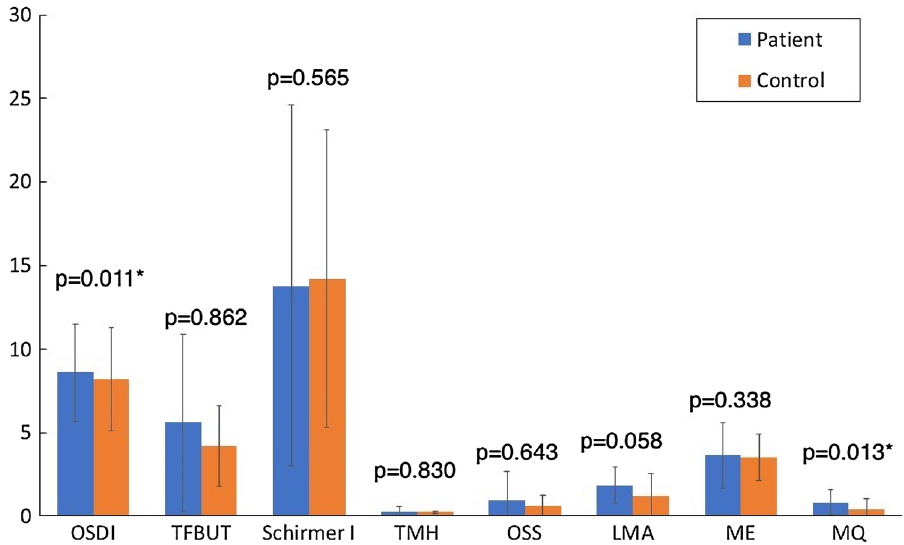
Figure 2. Clinical dry eye tests in patients and controls. OSDI Ocular Surface Disease Index questionnaire, TFBUT tear film break-up time, TMH tear meniscus height, OSS ocular surface staining, LMA lid margin abnormality, ME meibomian gland expressibility, MQ meibum quality. *Statistically significant inter-group difference tested with Mann–Whitney U test.